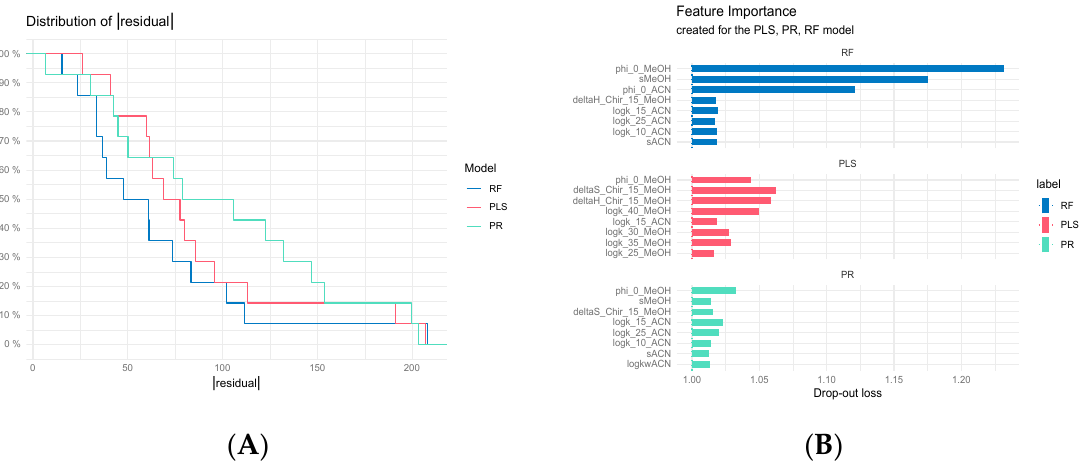
Figure 12. Distribution of residuals ( A ), variable importance for set of optimal RFE predictors ( B ) of three estimated models.